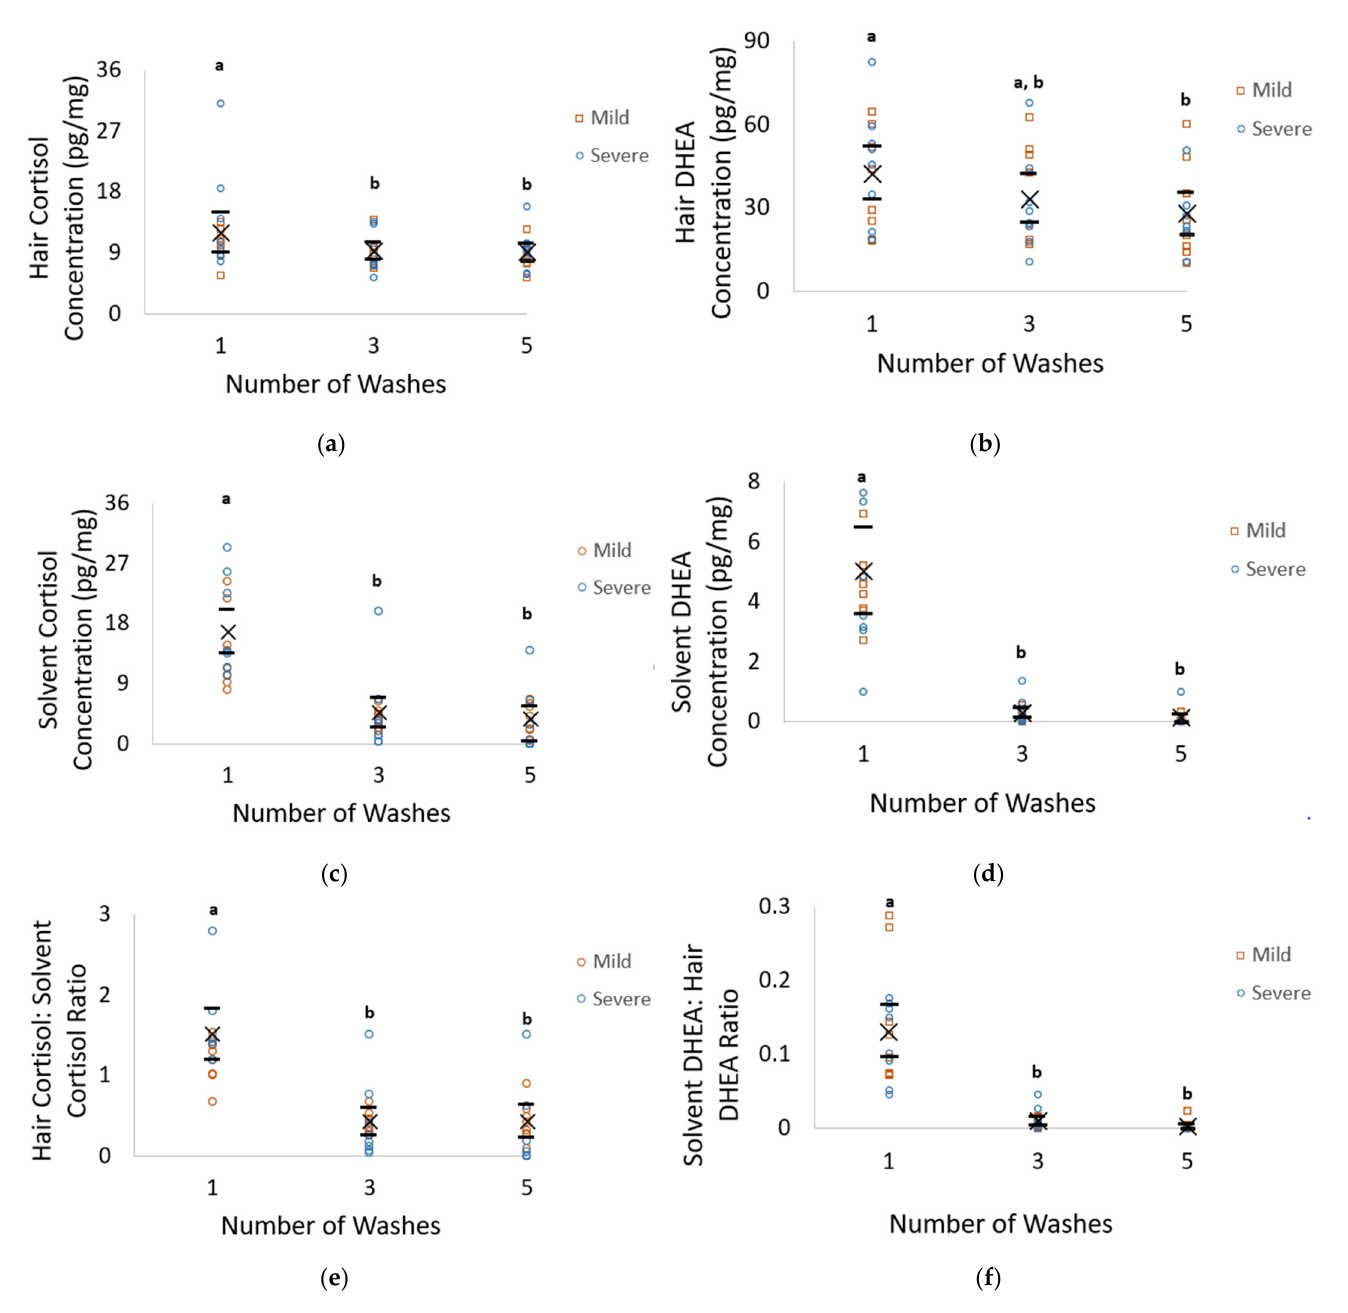
Figure 2. Hair cortisol ( a ) and DHEA ( b ), solvent cortisol ( c ) and DHEA ( d ) concentrations (pg/mg), and the solvent – cortisol ( e ) and solvent – DHEA ratios ( f ) following one, three, and five methanol washes of contaminated grower pig hair ( n = 16 per treatment). Within a figure graph, different letters denote significant differences between treatment groups ( p < 0.05), means are represented by ×, and the 95% confidence intervals are represented by black horizontal bars. Significant mean differences in raw data were as follows: hair cortisol (2a): one wash vs. three washes: 2.76 pg/mg, one wash vs. five